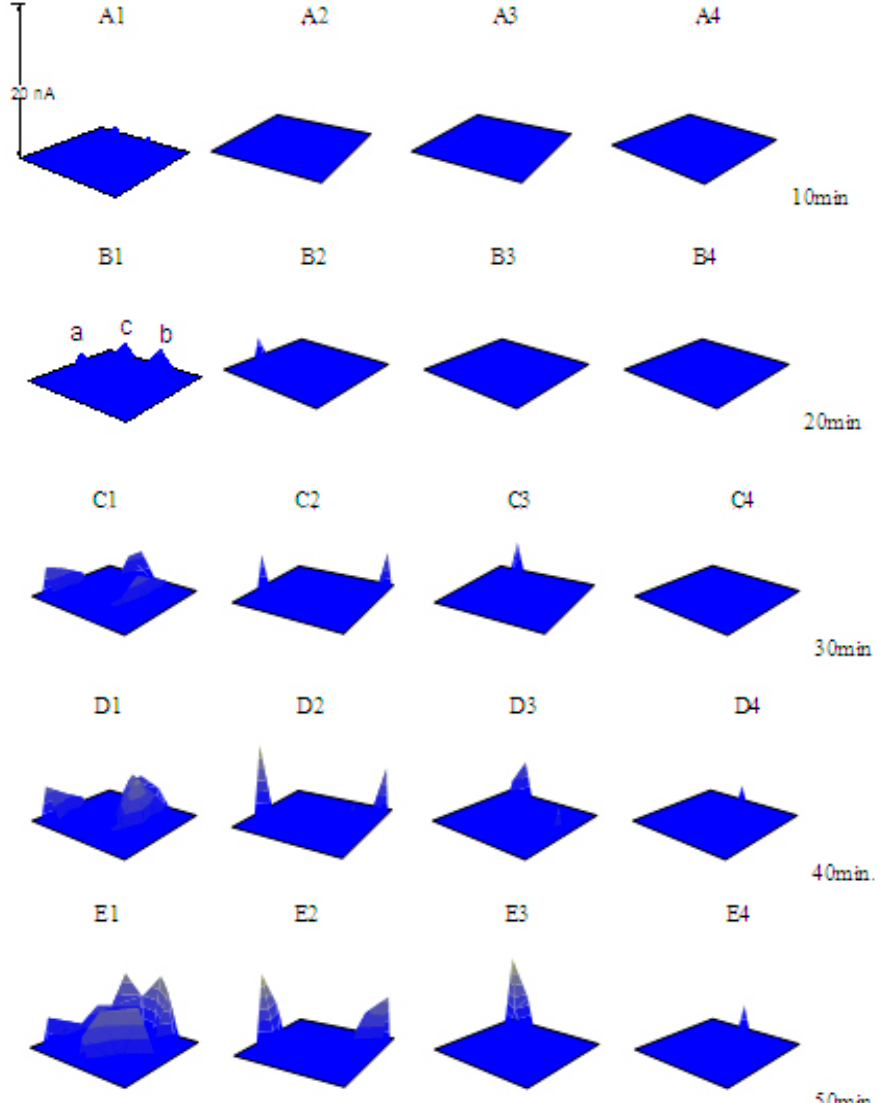
Figure 5. The scanning electrochemical microscope (SECM) images of the X70 carbon steel electrodes polarized at − 0.290 V ( E OCP = − 0.540 V) in 0.10 mol/L NaCl + x mol/L Na 3 PO 4 solutions ( A1 – E1 ) x = 0.020; ( A2 – E2 ) x = 0.040; ( A3 – E3 ) x = 0.060; ( A4 – E4 ) x = 0.080.